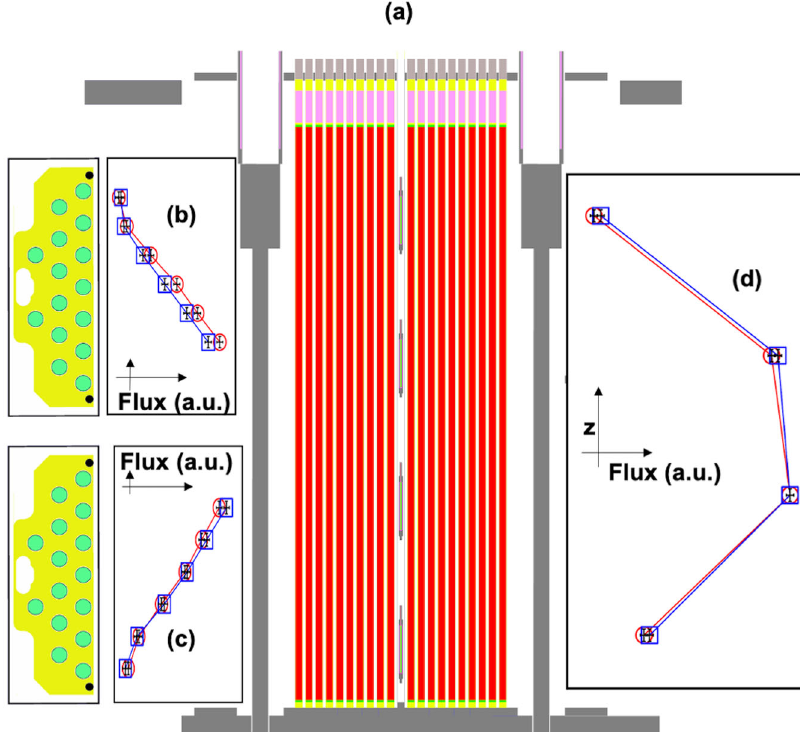
Fig. 2 Comparison between numerical and experimental axial fl ux measured at the Reactor Critical Facility (RCF). a Side view of the MORET6 model of the RCF reactor equipped with the four central 3 He tubes and with the two lateral NoMAD detectors. b , c Axial fl uxes measured at P = 0.79mW (blue squares) and simulated at P = 0.79 mW (red circles) using the NoMAD detectors. d Axial fl uxes measured at P = 0.79 mW (blue squares) and simulated at P = 0.66 mW (red circles) using the 3 He inner detectors. Statistical error bars where evaluated using bootstrap both for simulated and experimental data. Systematic error bars on the positioning in z of 3 He tubes within the NoMAD detectors have been evaluated to be approximately of 1 cm, and have been reported both on simulated and experimental data. All error bars lie within the squares and circles symbols. Both axial "cosine" shapes are within 2- σ agreement for the inner 3 He detectors, while a systematic underestimation of the simulated fl ux appears on the top NoMAD detector. This might be attributed to the positioning of the detector during the experiment, which might have been slightly displaced during the reactor